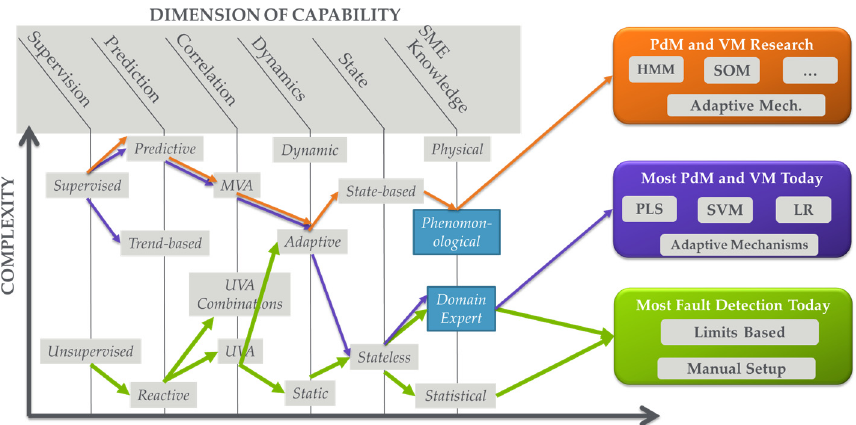
Figure 3. Dimensions of analytics capabilities with mapping of typical advanced process control (APC) solutions in semiconductor manufacturing to these dimensions.